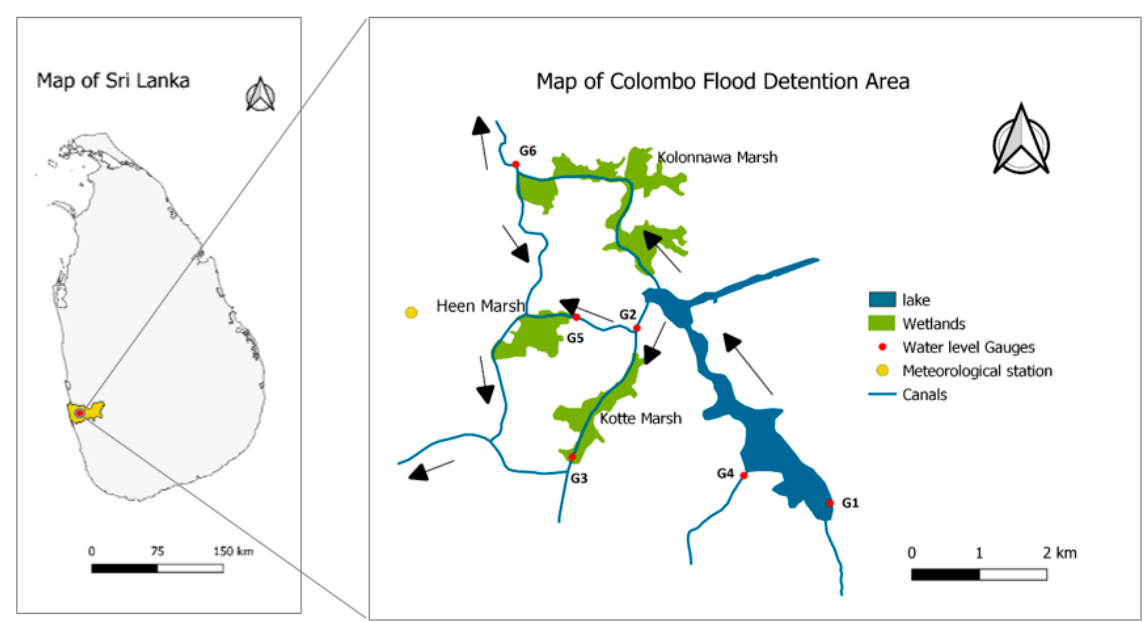
beige dot. The arrows show the flow directions and the connectivity among the three wet- lands.